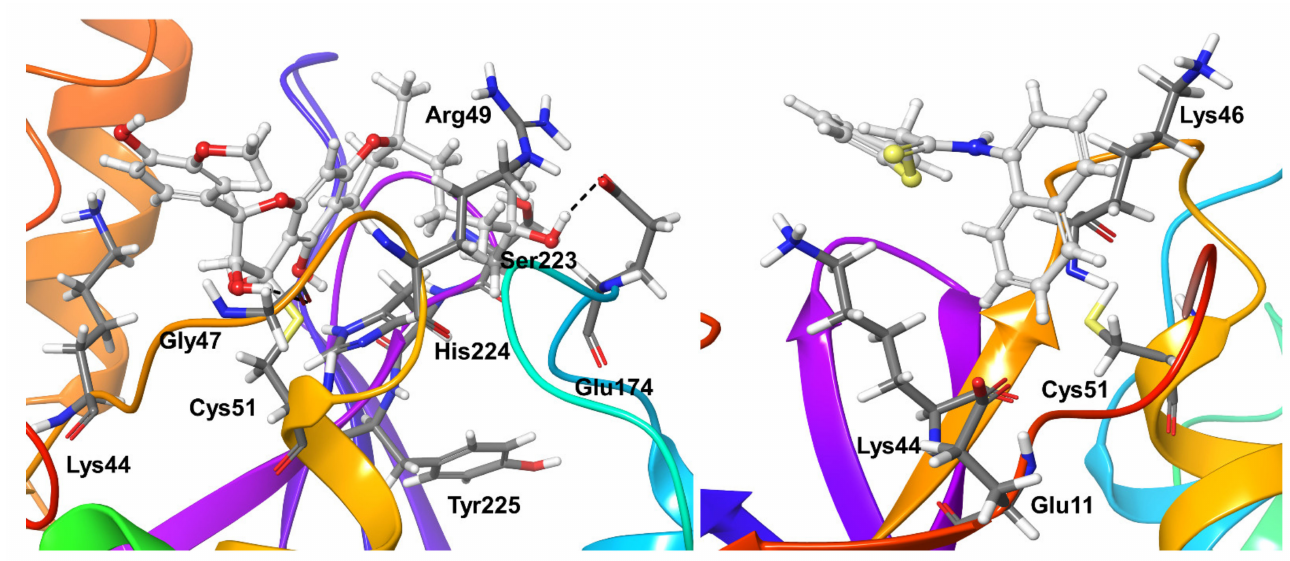
Figure 12. Stable ligand-protein interactions during MD refinement simulations of top poses of Compound 5 ( left ) and 6 ( right ) with OTUB-2. The compounds are shown in ball and stick representation, stable and moderately stable protein-ligand interactions are represented as thick tubes, and short-living interactions (present for less than 30% of simulation time) are shown as thin